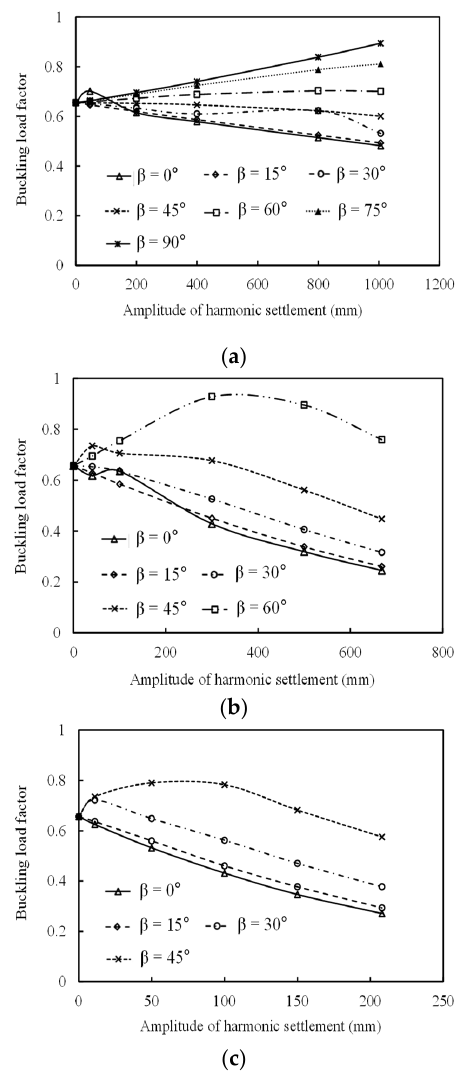
Figure 16. Amplitude of the harmonic settlement versus buckling load factor: ( a ) n = 2; ( b ) n = 3; ( c ) n = 4.